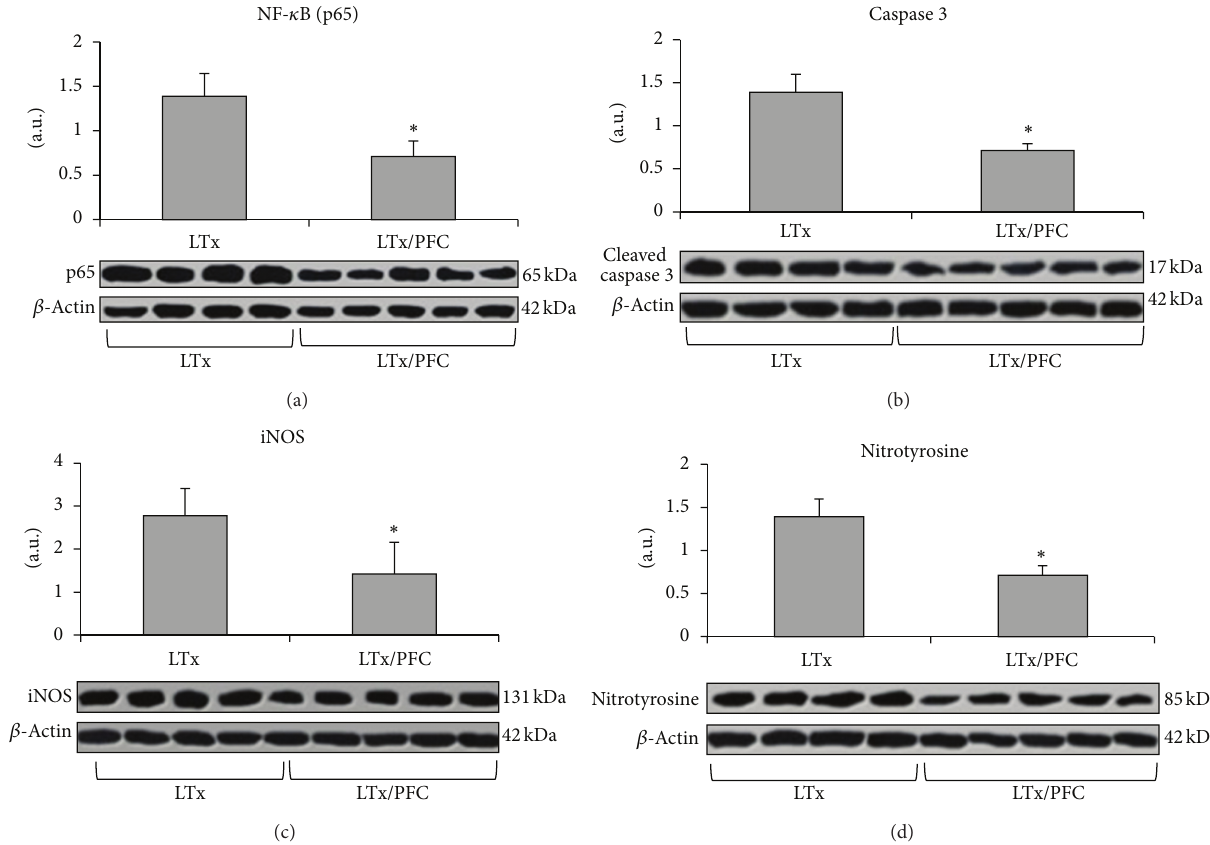
Figure 3: Apoptosis and inflammatory activity after lung transplantation. (a) Expression of NF- 𝜅 B (subunit p65) in the lung tissue after transplantation. There was an increased expression of NF- 𝜅 B subunit p65 in the LTx group compared with the LTx/PFC group ( ∗ 𝑃 < 0.05 ). The images are representative samples of the groups. (b) Caspase 3 expression in the lung tissue after transplantation. There was a significant reduction in the expression of caspase 3 in the LTx/PFC group ( ∗ 𝑃 < 0.05 ) compared with the LTx group. The images are representative samples of the groups. (c) Effect of lung transplantation on iNOS activity. iNOS activity was significantly higher in the LTx group ( ∗ 𝑃 < 0.05 ). These results indicate that LTx induced the overexpression of iNOS, and the PFC treatment reduced iNOS expression. The images are representative samples of the groups. (d) Expression of nitrotyrosine in the lung tissue after transplantation. Nitrotyrosine expression was significantly lower in the LTx/PFC group compared with the LTx group ( ∗ 𝑃 < 0.05 ). The images are representative samples of the